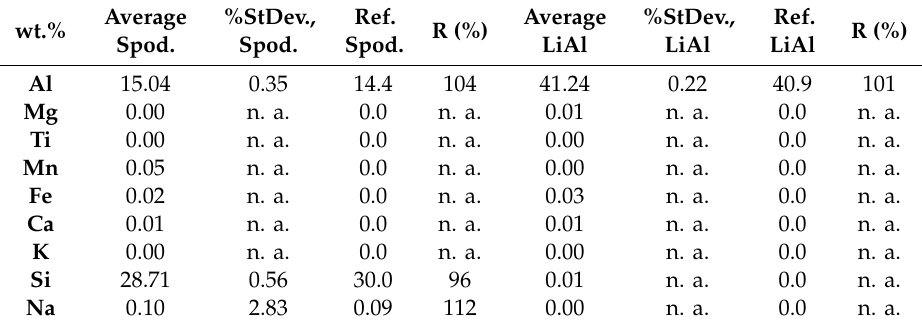
Table 2. Repeated Measurements on Two Li-Compounds. Spod, Spodumene; %StdDev, Percentage Standard Deviation of the Measured Points (pepeats: n = 5); R, Recovery; LiAl, LiAlO 2 .